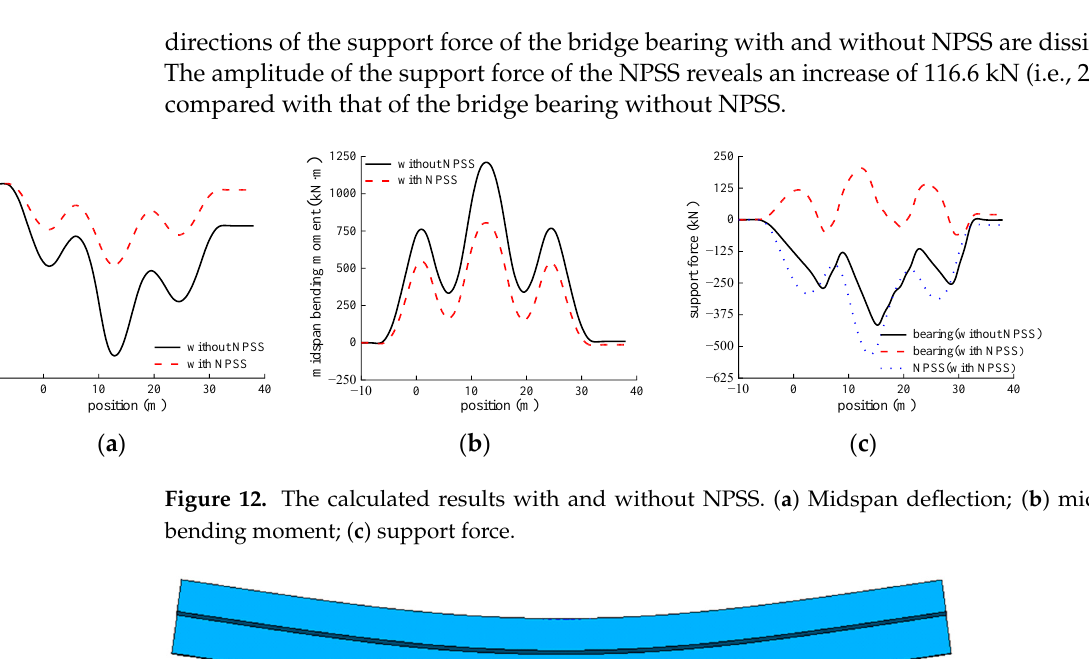
Figure 11. Parameters of the applied load (unit: cm).